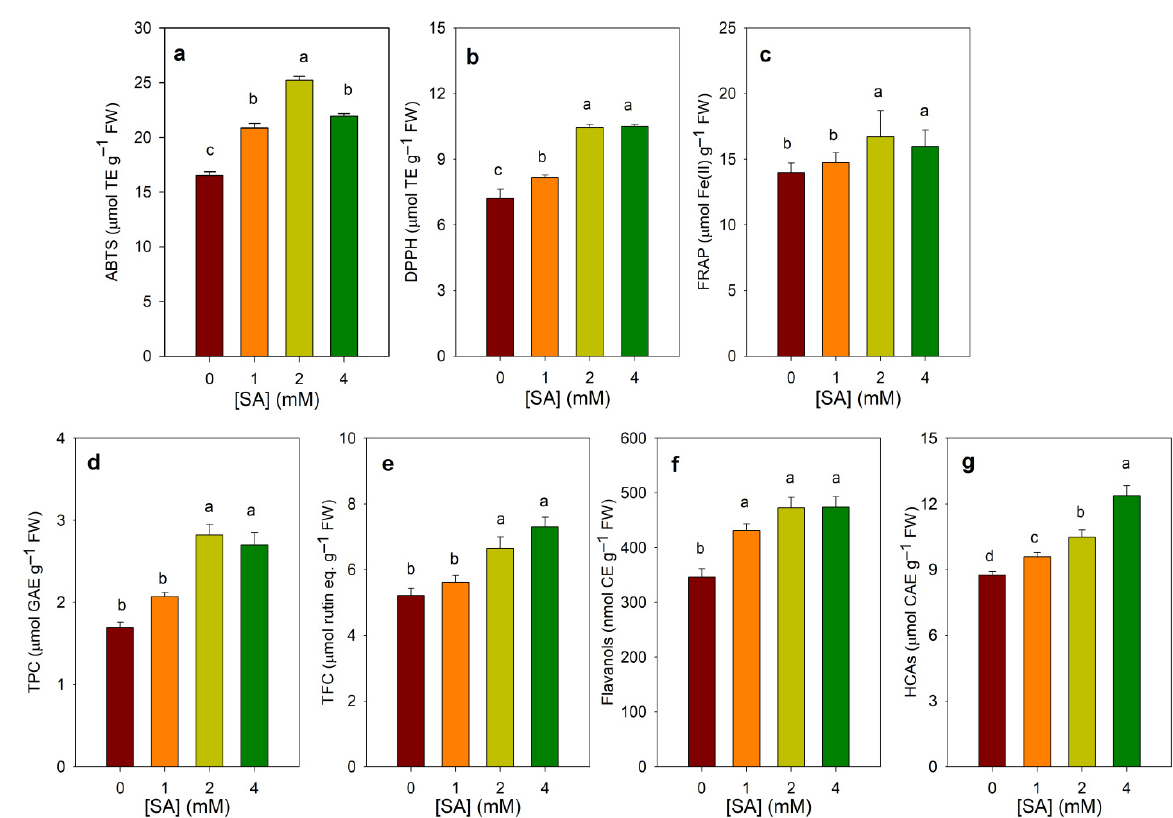
Figure 3. Effect of foliar SA applications on total antioxidant activities ( a – c ), and phenolic contents ( d – g ) in leaves of 45-day-old okra plants. ( a ) ABTS •+ - radical scavenging activity; ( b ) DPPH •